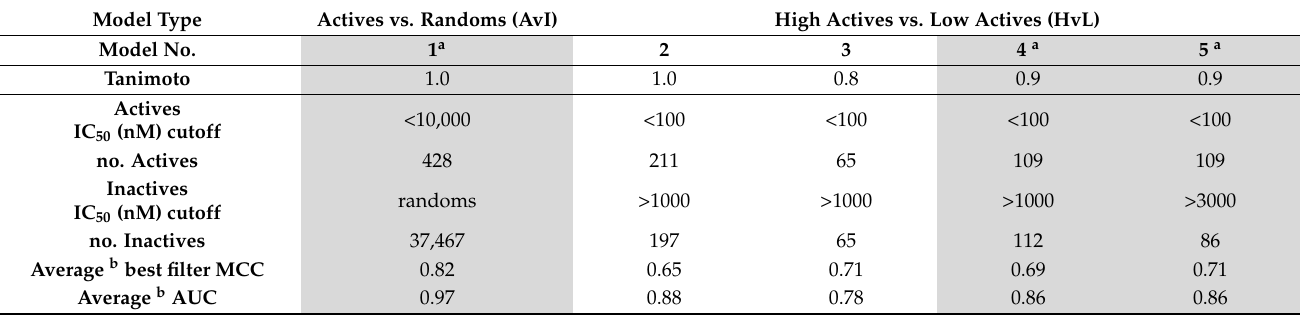
Table 2. Comparison of AChE ISE models’ properties and